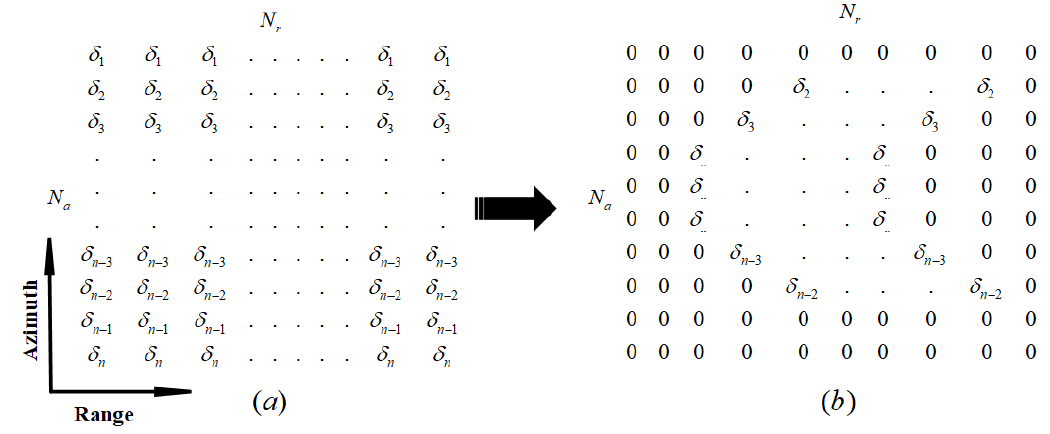
19 of 31 Figure 7. Variation in backscatter coefficient in synthetic aperture: ( a ) the point target corresponds to a certain number of discrete electromagnetic waves, which is usually equal to the number of azimuth sampling points within synthetic aperture time; ( b ) magnitude spatial distribution of point target.